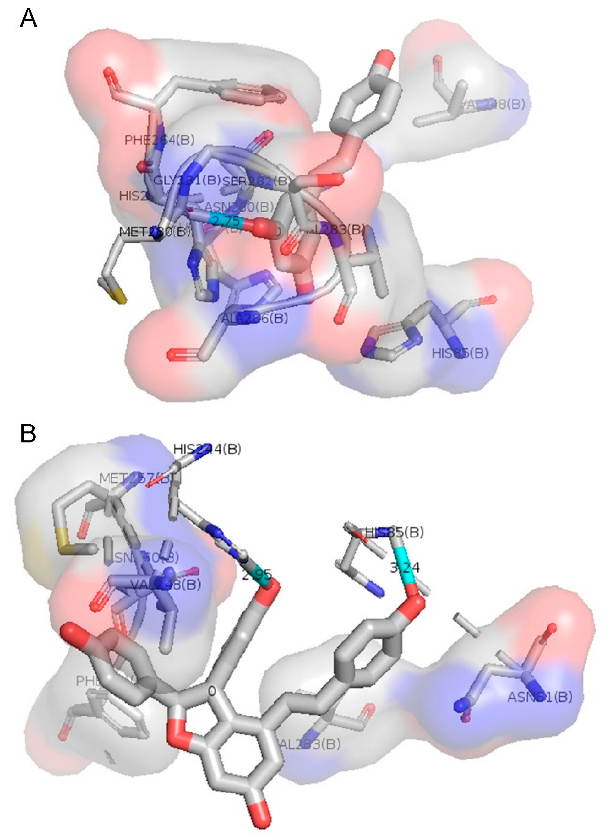
Figure 5. Molecular docking simulations of binding tyrosinase and E -resveratrol ( A ) and E - ε -viniferin ( B ).